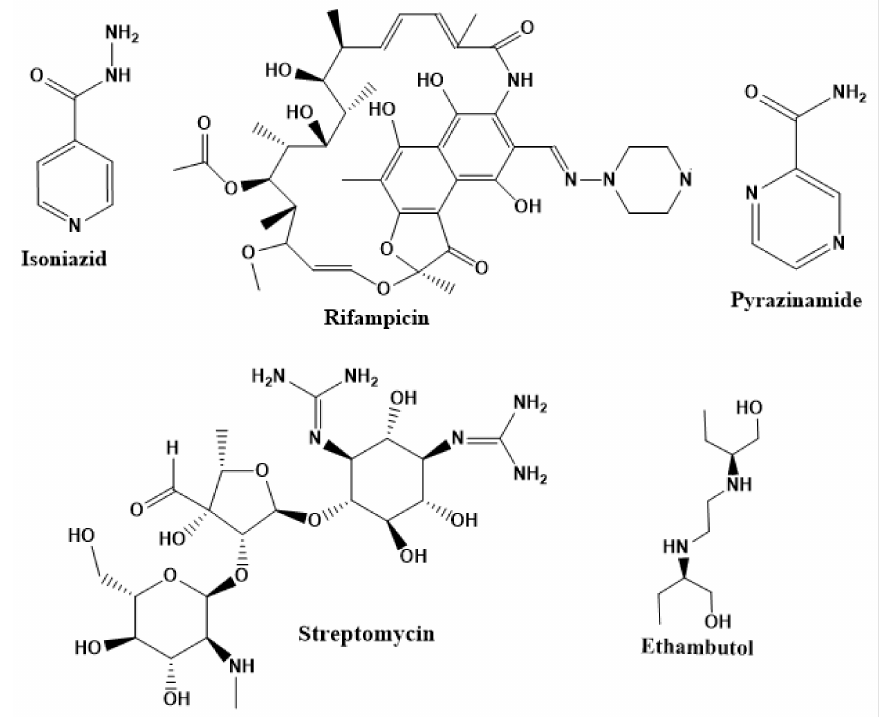
Figure 3. Chemical structures of first-line drugs used in management of